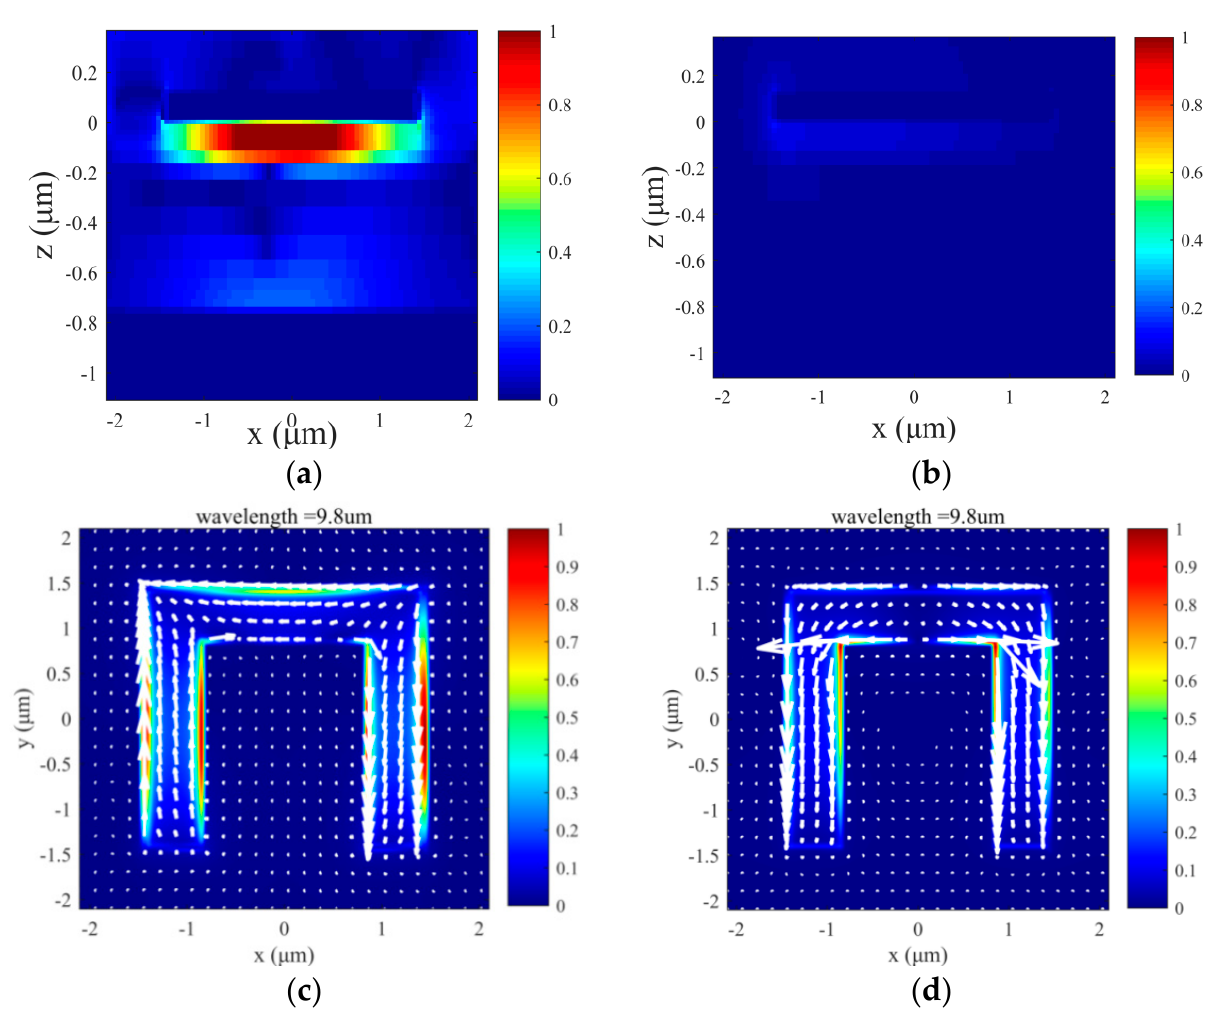
Figure 3. The calculated electric field intensity profile of U-shaped antenna incident by RCP wave at with the resonant wavelength λ = 9.8 µ m for ( a ) amorphous and ( b ) crystalline states of Ge 2 Sb 2 Te 5 ; ( c , d ) the electric displacement profile under LP waves along the ( c ) x (symmetric) and ( d ) y (asymmetric) directions.